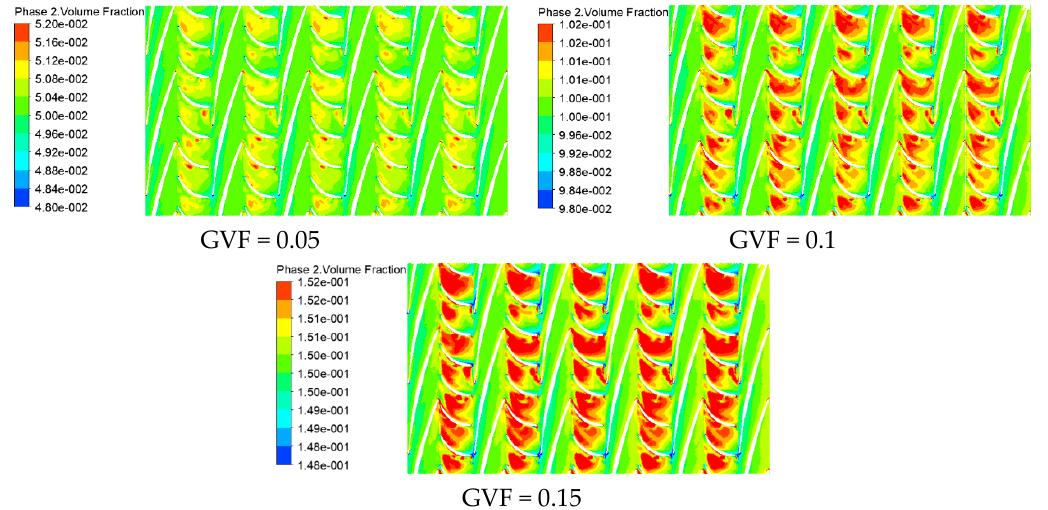
Figure 7. The gas-phase volume distribution in the pressurization unit at 0.2 times the height of the blade at different GVFs.